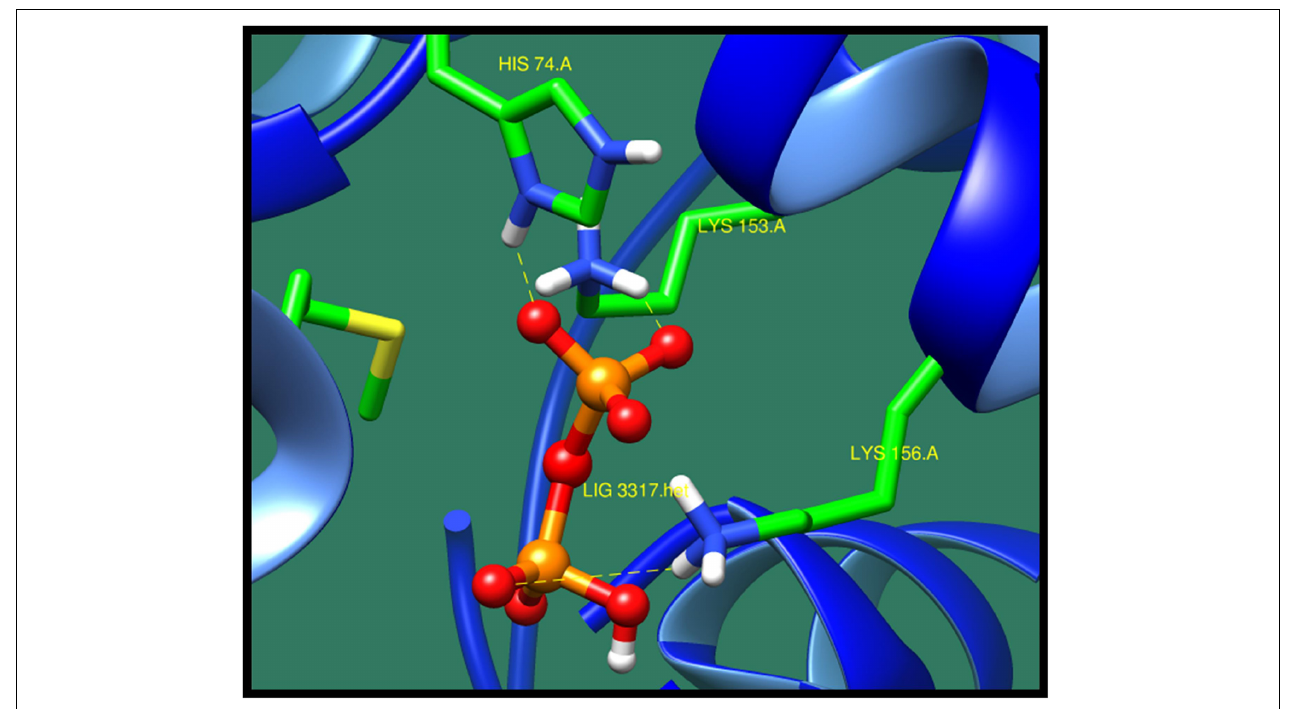
FIGURE 14 | Interaction of DNA-binding response regulator with ZINC38140720 (colored in red). The interacting residues (green) are shown bonding (dotted lines) with the